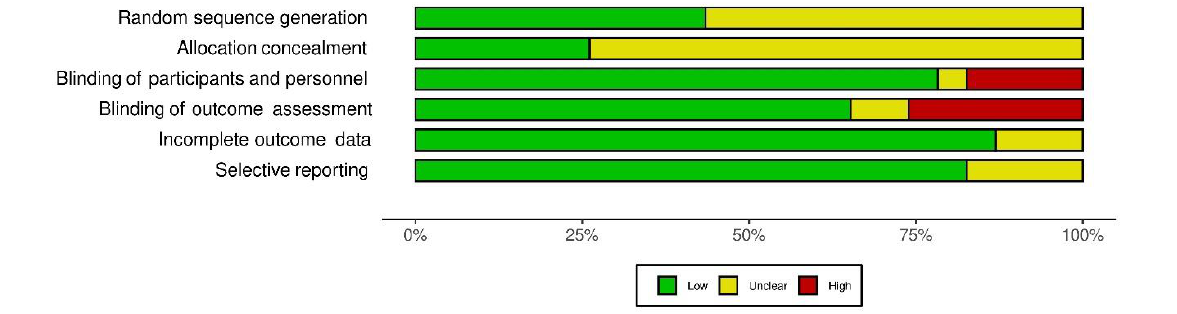
Figure 3. The quality of included RCTs: risk-of-bias per item presented as percentages across all included RCTs.